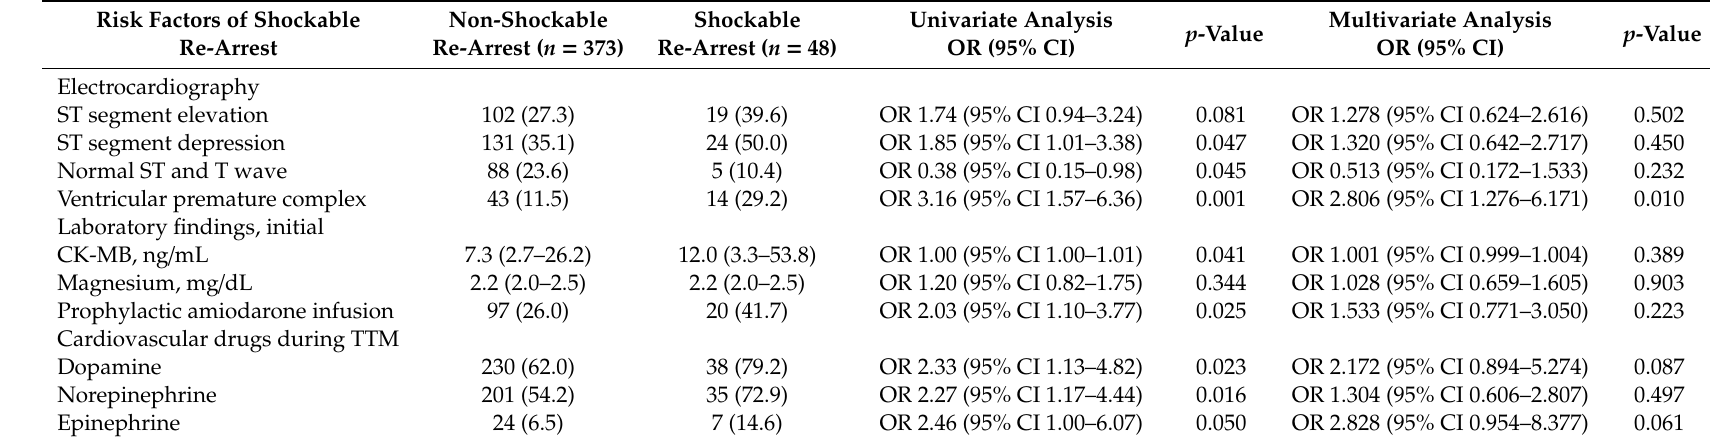
Table 4. Univariate and Multivariate analysis in factors associated with recurrent shockable cardiac